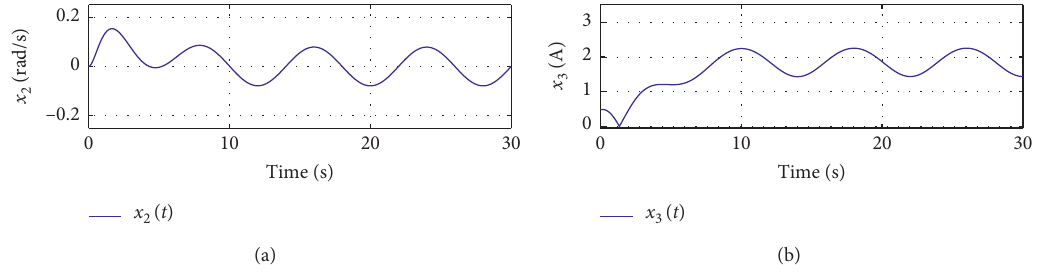
Figure 6: State behaviour in a sinusoidal trajectory.